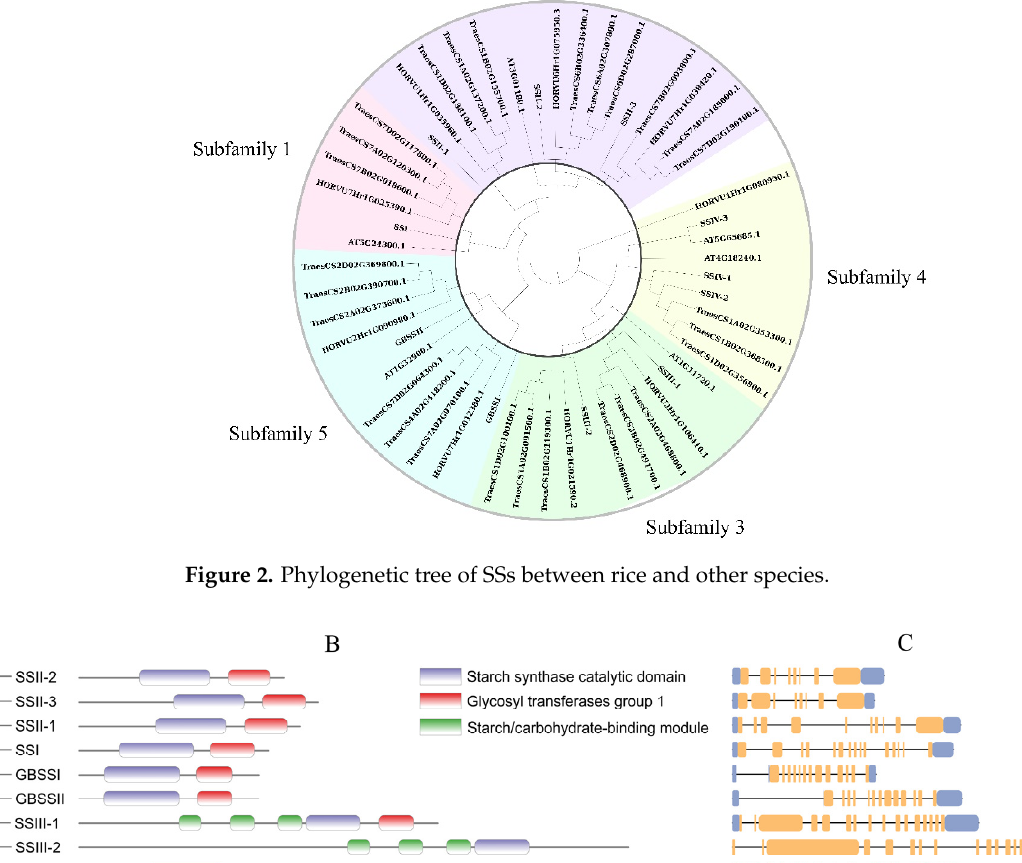
Figure 3. The OsSS gene family structure based on a phylogenetic tree. ( A ) Phylogenetic 122 relationship of OsSS; ( B ) prediction of domain structure; and ( C ) gene structure. The numbers 123 below A and B represent the length of the amino acid (aa) and target sequence (bp), respectively. 124